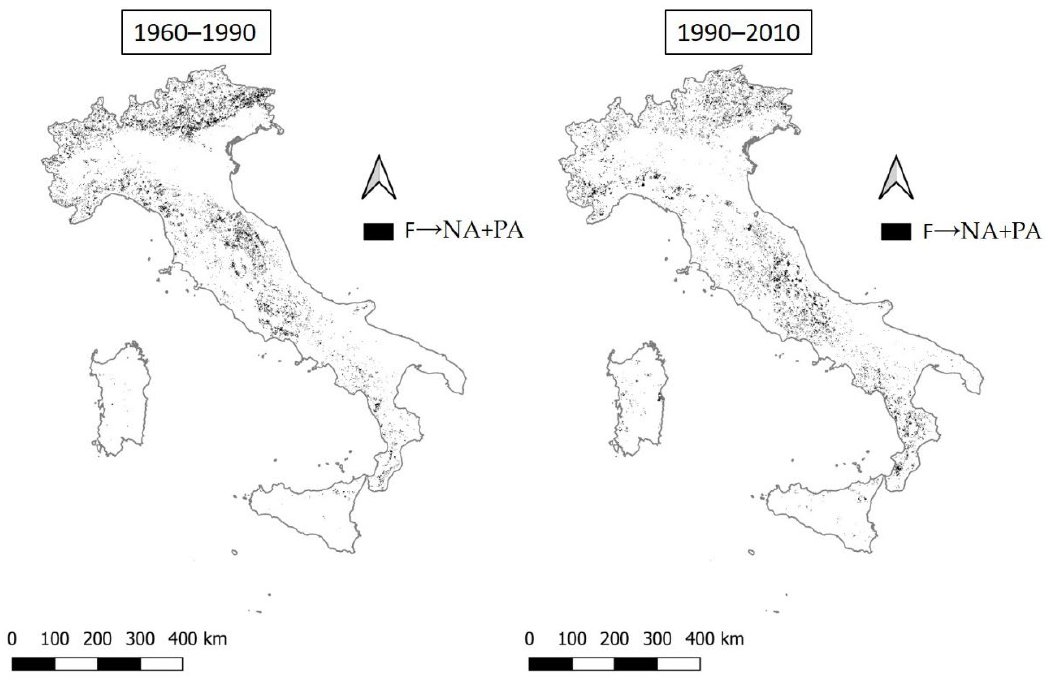
Figure 10. The transition from fragile areas to not affected or potentially affected areas (F → NA + PA) in the two time intervals 1960–1990 and 1990–2010.